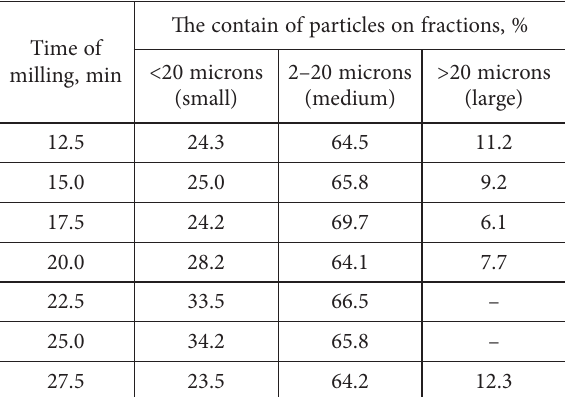
Table 1. Distribution of press-powder particles by size Time of milling, min